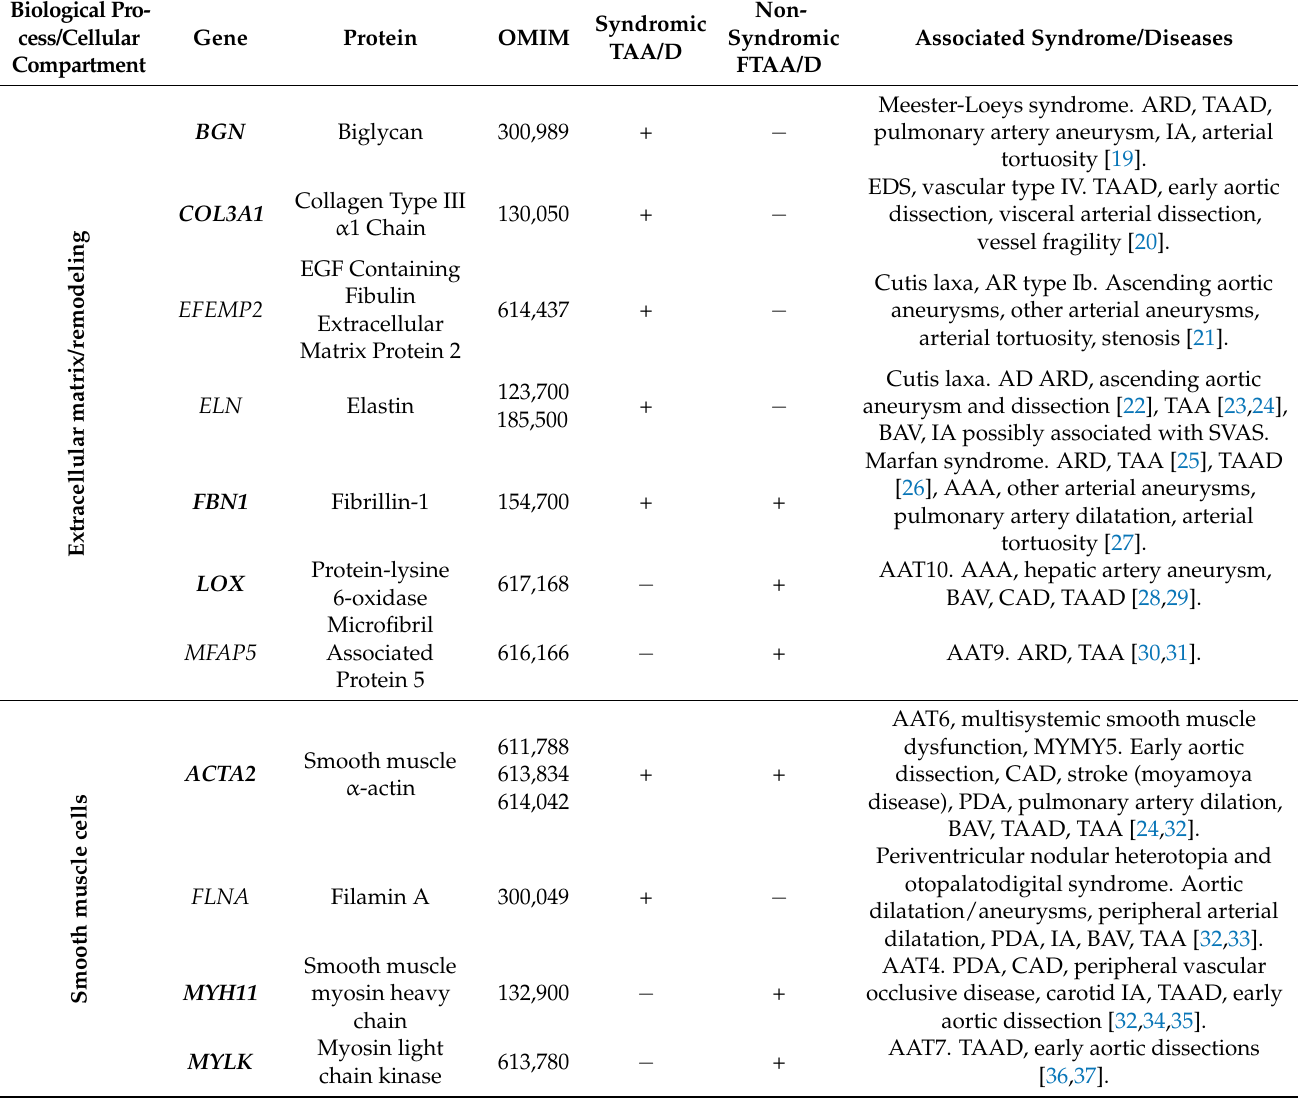
Table 1. Genes associated with TAA/D (syndromic and